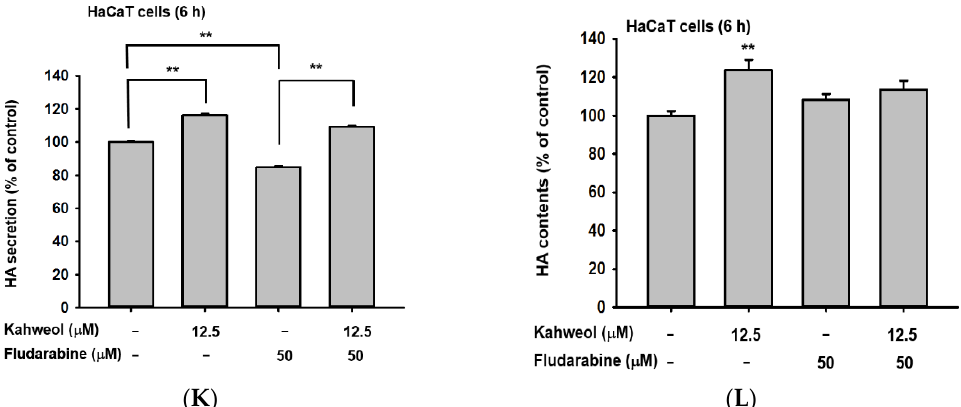
Figure 3. Effect of kahweol on transcription factor regulation. ( A – E ) AP-1–, NF- κ B–, CREB-, STAT3-, and STAT1-mediated luciferase activities in HEK293T cells were measured by reporter gene assay with an illuminometer. ( F ) The occludin- and total protein levels of STAT1 and β -actin in whole-cell lysates were measured in kahweol-treated HaCaT cells. ( G ) The cytotoxicity of fludarabine in HaCaT cells and HEK293T cells was evaluated by MTT assay. ( H ) After pretreatment with fludarabine for 30 min in HEK293T cells, kahweol was then administered for a further 12 h to HEK293T cells. STAT1- mediated luciferase activity was then measured by reporter gene assay using an illuminometer. ( I , J )The mRNA levels of HAS2 , occluding , and HYAL-4 in kahweol-treated HaCaT cells pre-treated with fludarabine were determined by RT-PCR ( I ). The relative intensity of mRNA levels of HAS2 , occluding , and HYAL-4 was measured by ( J ). ( K,L ) After 30 min of fludarabine pretreatment, kahweol was then given for further 6 h, supernatant media was collected to detect HA secretion ( K ), and HaCaT cells were harvested to detect cellular HA contents ( L ). * p < 0.05 and ** p < 0.01 compared to the normal group.